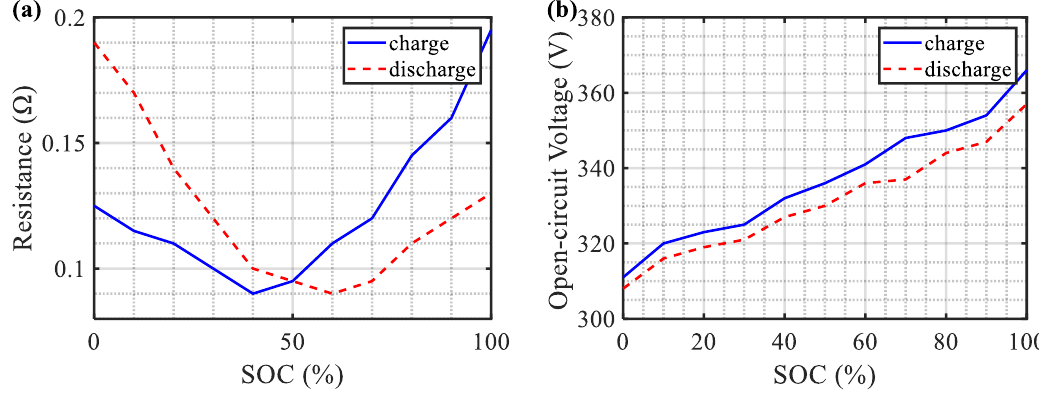
Figure 3. ( a ) Internal resistance of the battery; ( b ) open circuit of the voltage of the battery. The battery’s open circuit voltage and equivalent internal resistance have a mapping relationship with the state of charge ( SOC ) of the battery when the battery is discharged or charged. The changes in battery currents under the two states can be expressed as: